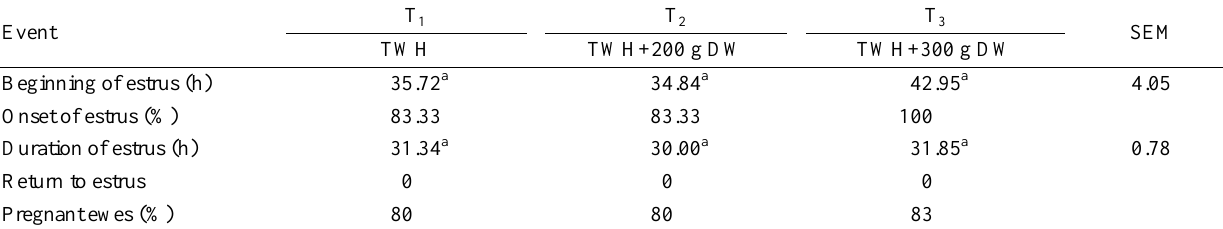
Table 3. Estrus behavior and pregnant rate